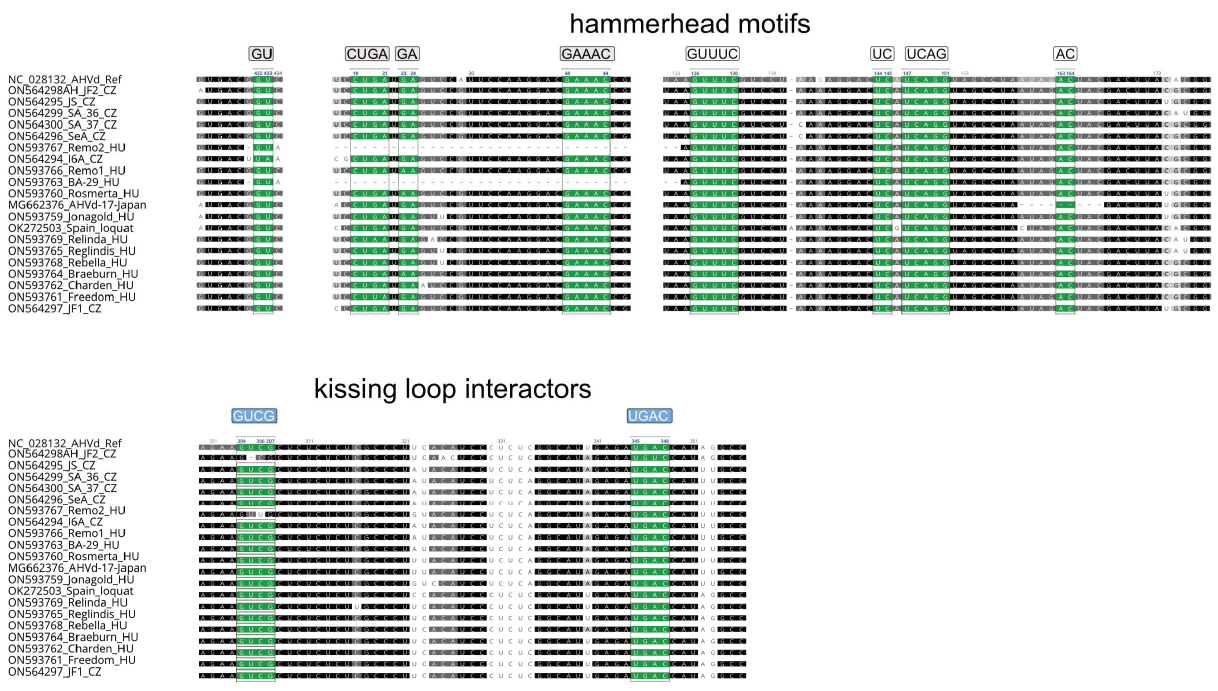
Figure 4. Alignment of the hammerhead-motif-containing part of the AHVd variants, including the reference-resembling and deletion-containing variants from Japan and the Spanish loquat. Residues forming the hammerhead motifs are highlighted in